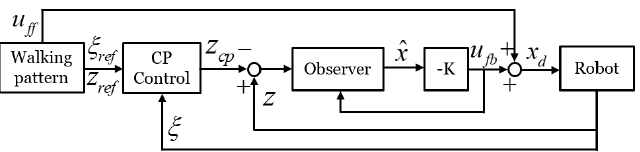
Figure 7. Block diagram of proposed ZMP controller.